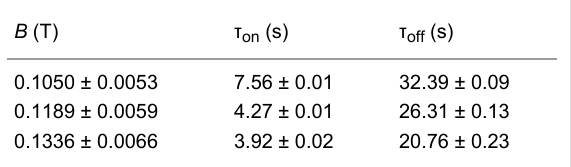
Table 1: Relaxation times for the cell with the mixture of 5CB with CoFe 2 O 4